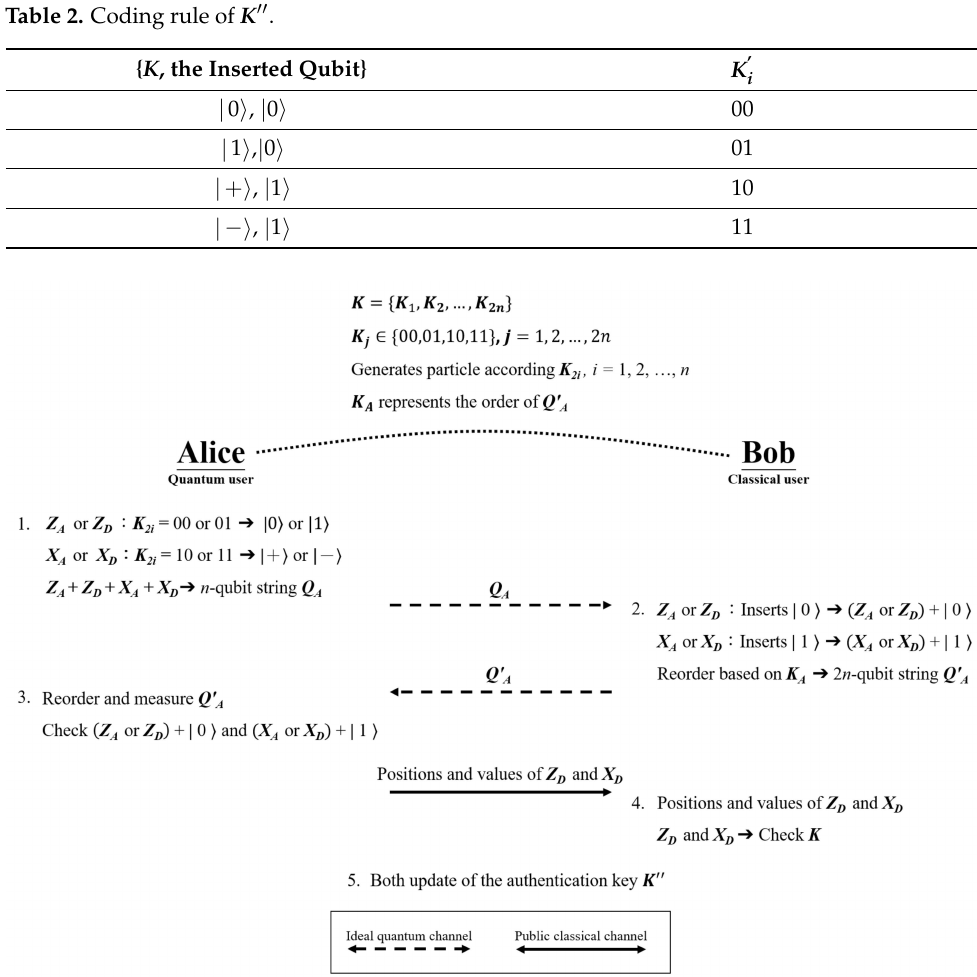
Figure 6. The proposed measurement-free SQA